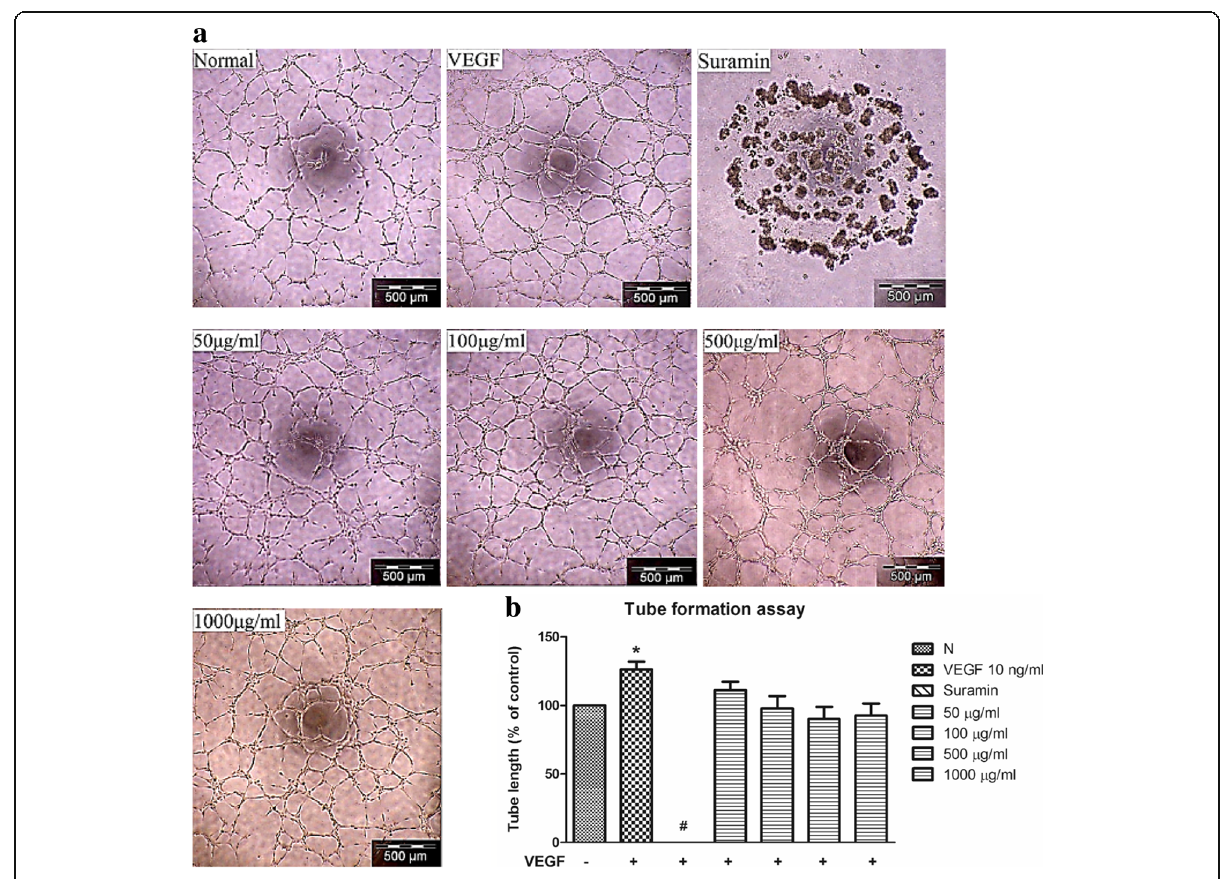
Fig. 6 Effect of C. nutans water extract on VEGF-induced capillary-like endothelial tube formation. a Microscopic examination demonstrated C. nutans extract does not suppressed VEGF-induced capillary-tube like formation in comparison with VEGF group. b Capillary-tube like vessel density was calculated and compared. The values presented are the mean ± SEM of three independent experiments. * p < 0.05 were considered significant when compared to normal control (N); # p < 0.05 were considered significant when compared to VEGF alone group